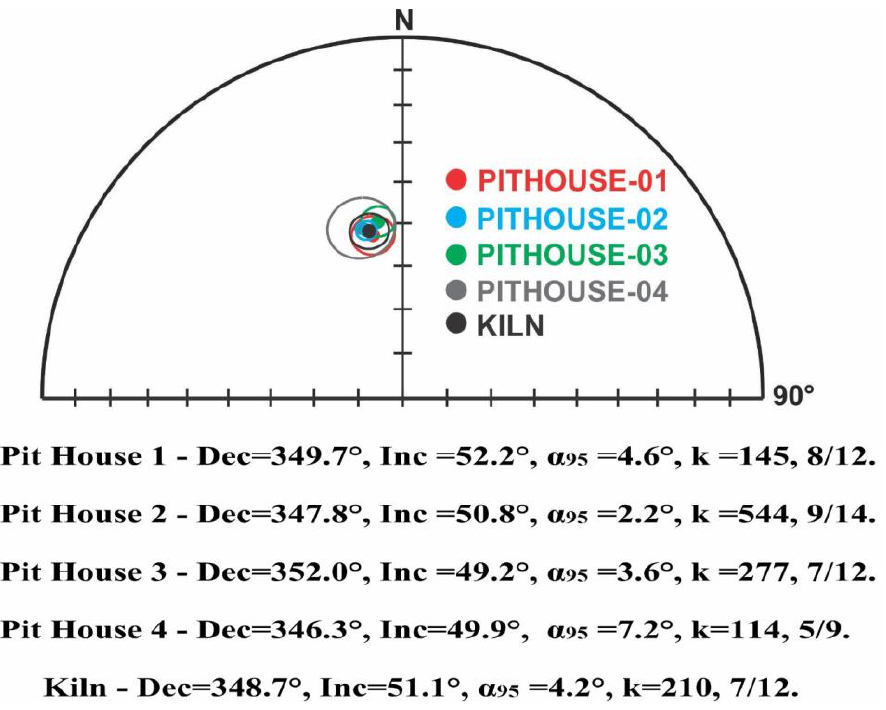
Figure 6. Equal area projection of mean archaeomagnetic directions for four Pit Houses and one kiln (horno).